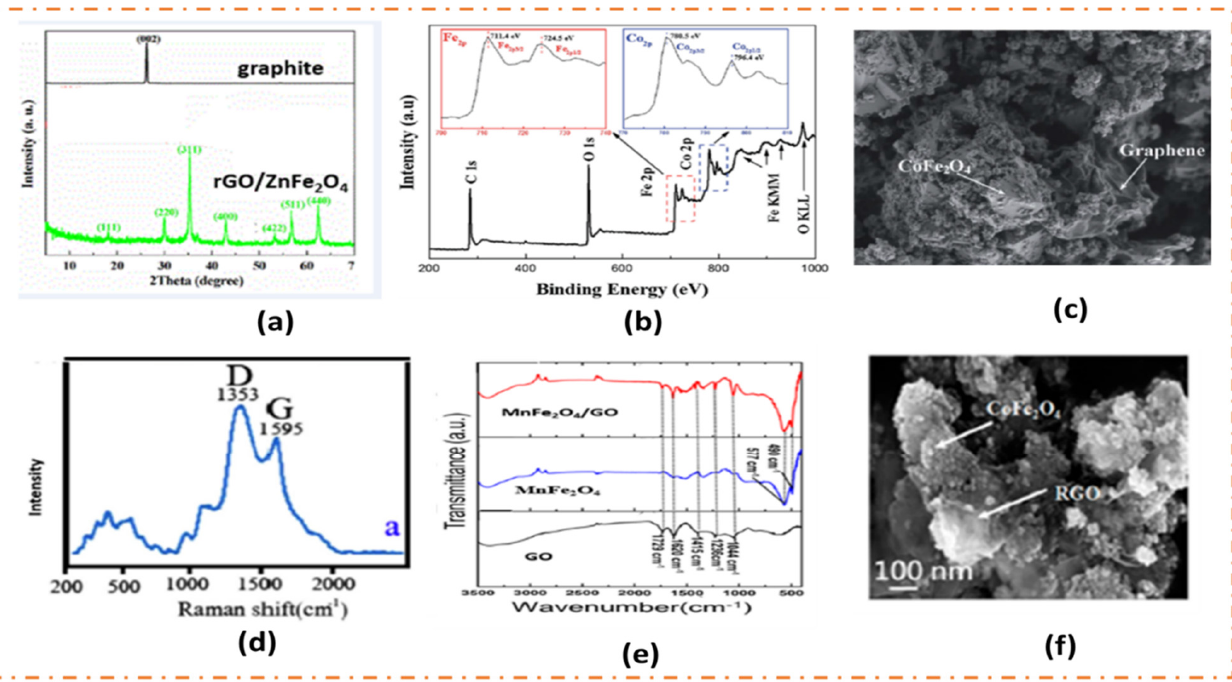
Figure 1. ( a ) XRD patterns for graphite and rGO/ZnFe 2 O 4 “Reprinted/adapted with permission from Ref. [30]. 2016, Elsevier”. ( b ) XPS analysis of rGO/CoFe 2 O 4 “Reprinted/adapted with permission from Ref. [31]. 2017, RSC” ( c ) FESEM images of CoFe 2 O 4 /graphene composite showing firm adhe- sion between pristine SF and graphene “Reprinted/adapted with permission from Ref. [32]. 2021, RSC”. ( d ) Raman spectra of ZnFe 2 O 4 /rGO “Reprinted/adapted with permission from Ref. [33]. 2014, Elsevier”. ( e ) FTIR data for MnFe 2 O 4 , GO/MnFe 2 O 4 composite, and GO “Reprinted/adapted with permission from Ref. [34]. 2014, ACS”. ( f ) TEM image for rGO/CoFe 2 O 4 “Reprinted/adapted with permission from Ref. [36]. 2015, ACS”.